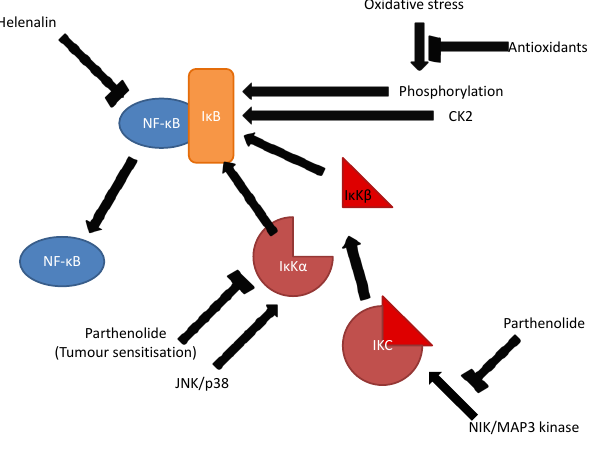
Figure 2. Activation and inhibition of NF-κB by different hypothesized interactions with parthenolide or helenalin. Parthenolide can act to alkylate IKC preventing a cell signaling cascade by NIK or MAP3 kinase stimuli, whereas helenalin is thought to directly modify the p65 subunit of NF-κB, inactivating the molecule. Tumor sensitization has been attributed to many varied mechanisms often unrelated to the NF-κB molecule, though it is postulated that one mechanism is via phosphorylation of IκB thus preventing deactivation by